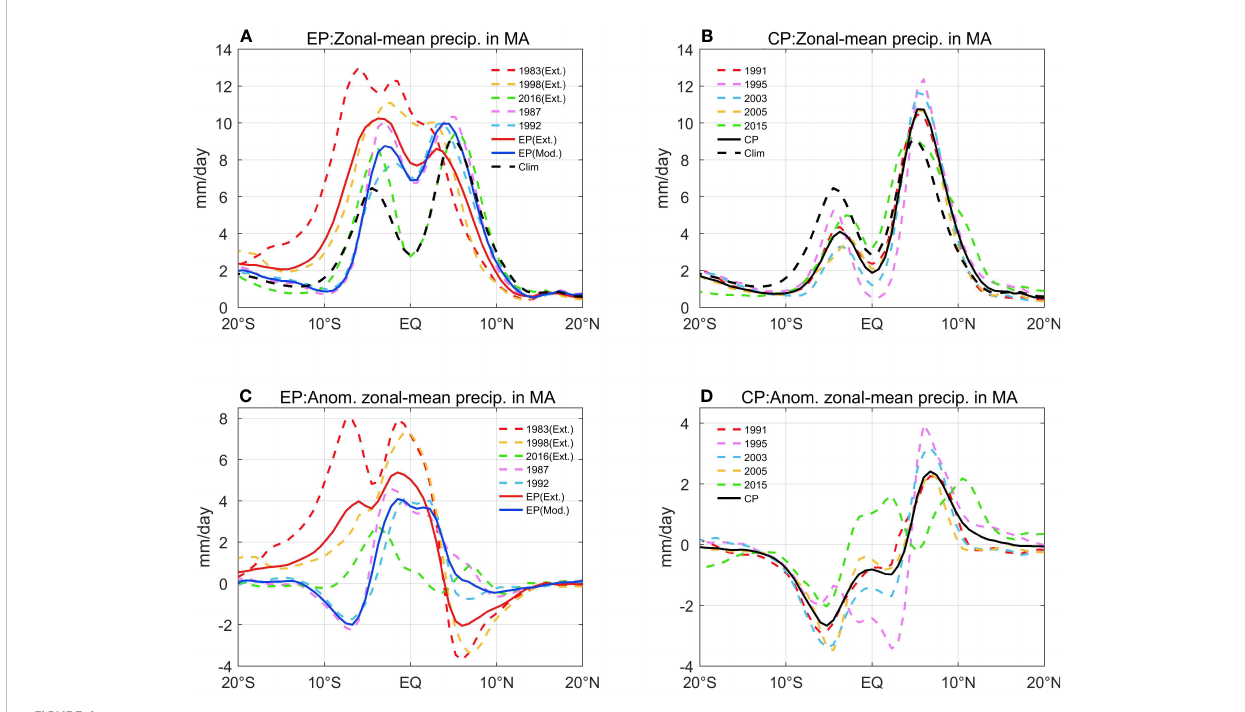
FIGURE 4 (A) zonal-mean precipitation (units: mm/day) over the eastern Paci fi c Ocean (140°W – 80°W) in March-April for: composite of extreme EP-type El Niños (red solid line), composite of moderate EP-type El Niños (blue solid line), climatology (black dashed line) and individual EP-type El Niños (colored dashed lines). (B) zonal-mean precipitation over the eastern Paci fi c Ocean in March-April for: composite of CP-type El Niños (black solid line), climatology (black dashed line) and individual CP-type El Niños (colored dashed lines). (C) as in (A) , but for the anomalous zonal-mean precipitation. (D) as in (B) , but for the anomalous zonal-mean